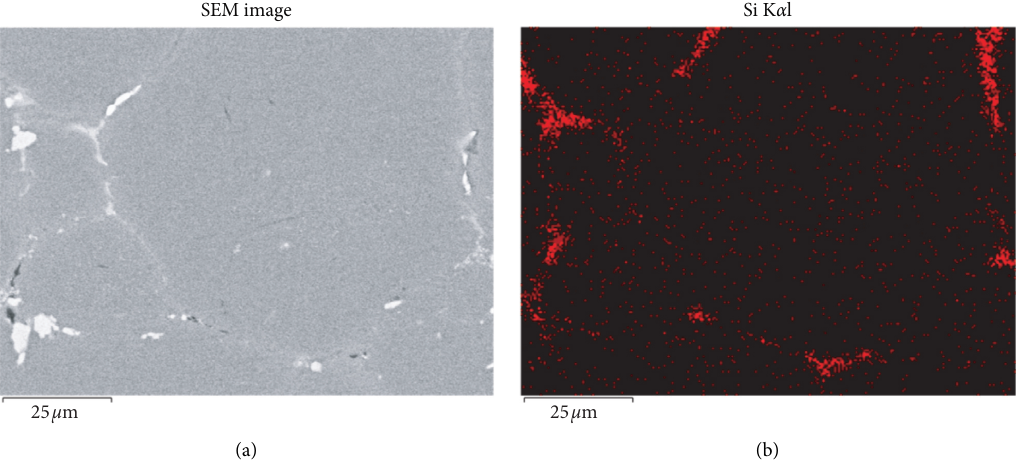
Figure 17: SEM image and EDS map of Si for the brazed specimen.